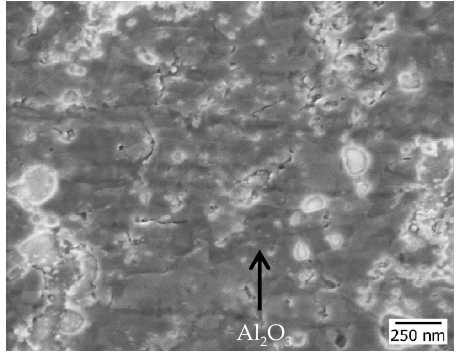
Figure 3. FIB image of compacted Cu-5wt.% Al 2 O 3 composite sinter.